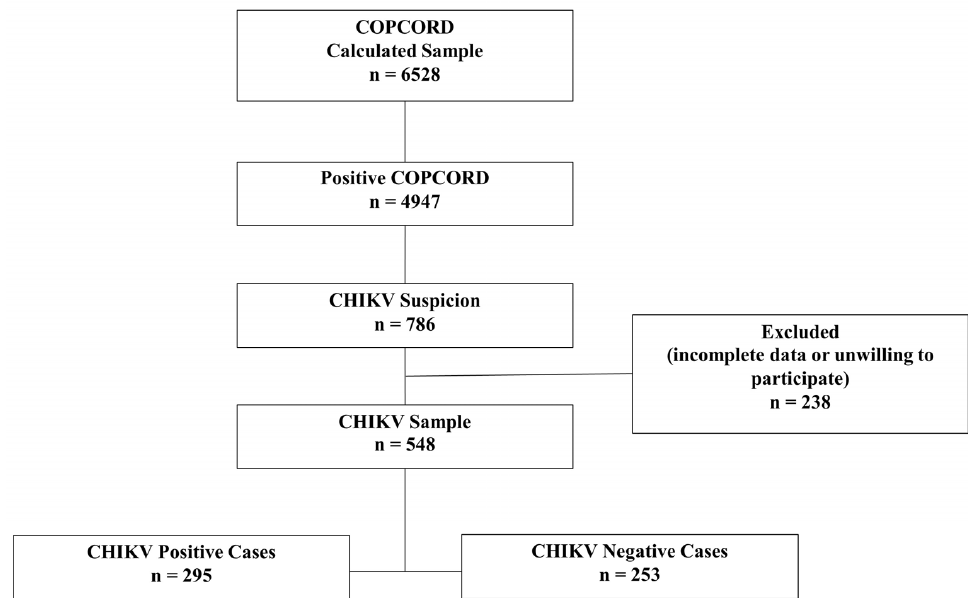
Figure 3. Profile of the study population. COPCORD: Community Oriented Program for Control of Figure 3. Pro fi le of the study population. COPCORD: Community Oriented Program for Control of Rheumatic Diseases; CHIKV: Chikungunya virus. Rheumatic Diseases; CHIKV: Chikungunya virus.